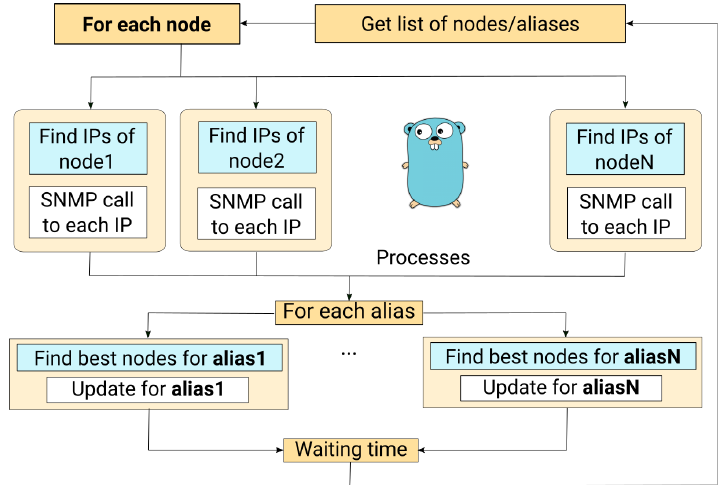
Figure 2: Workflow of the Load Balanced